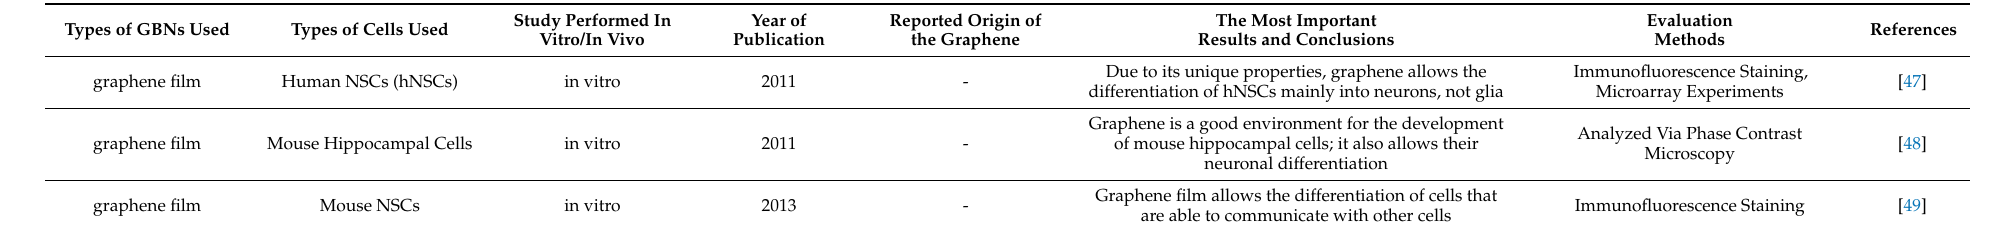
Table 5. List of relevant studies conducted with utilization of graphene